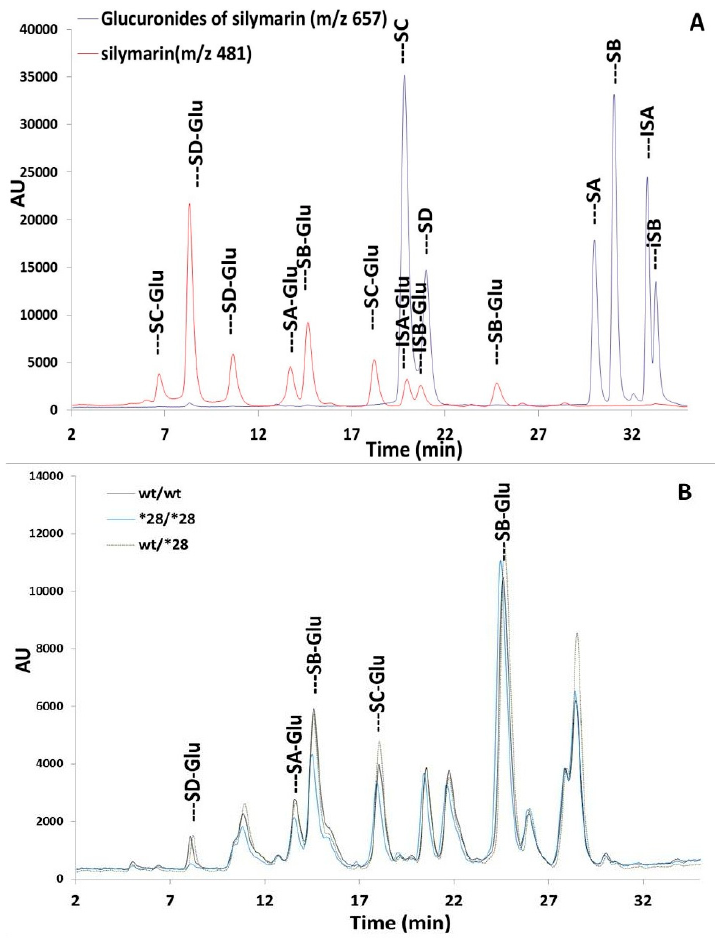
Figure 3. Chromatographic profiles of flavonolignan glucuronide conjugates. ( A ) Composite profile of